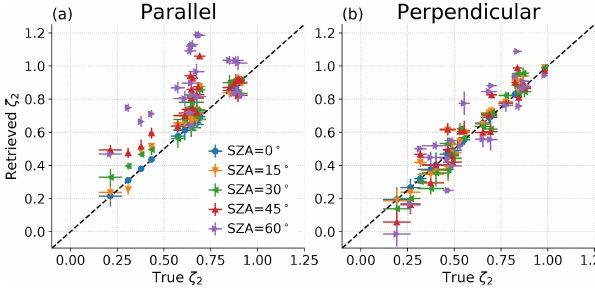
Figure 6. Estimated clear-sky ζ 2 over separations 0.5–1km in all 23 snapshots as a function of the true value. The error bars are ± 2 σ from the trend fit.